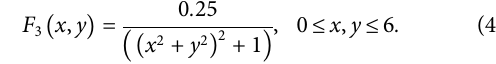
Frontiers in Physics |